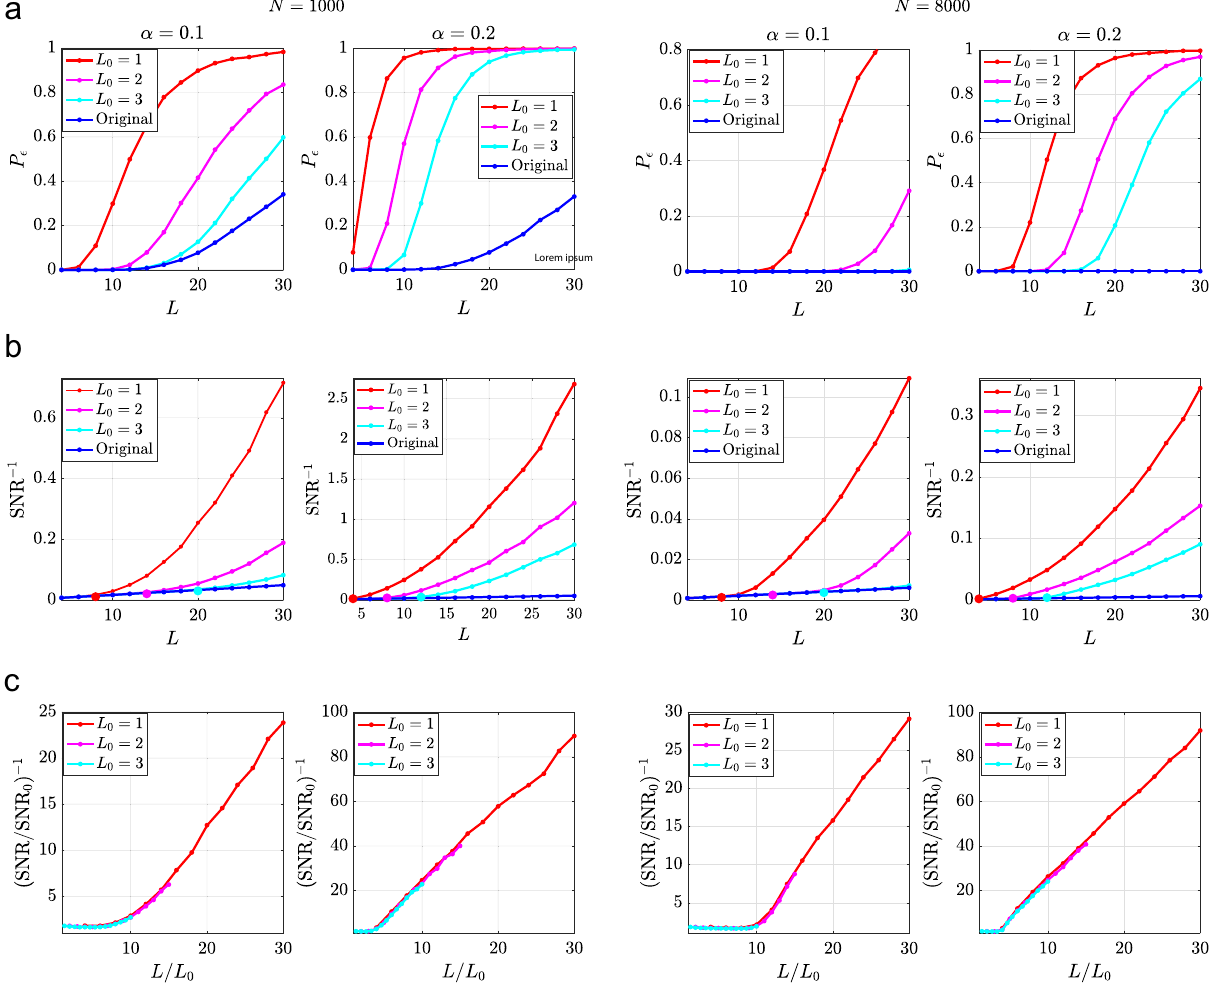
Figure 3. ( a ) The decoding error P ǫ is compared for several values of L 0 from structures containing L pairs of 1 items for two values of N and two values of α . ( b ) SNR − v. L . For each value of L 0 , l c is given by the value of L 1 where SNR − diverges from the line corresponding to the original structure, which is marked for each value 1 20 parallel updates are used in memory N T of L 0 . ( c ) ( SNR / SNR 0 ) − v. L L where SNR 0 L . For all figures, 0 = = 30 N retrieval and the average is performed over 10, 000 memories. The dictionary is fixed to D = Length of cueing structure and memory basins. As seen in Fig. 3, the performance worsens (and L 0 SNR decreases) as L increases, while the converse holds true for L 0 . We find that there is a critical ratio, l c L , = defined as the minimum initial cue (relative to the total length), that leads to very small error which is essentially L 0 2 m 0 corresponding memorized structure, which we denote m 0 . For small values of L 0 , m 0 π L . The size of ≈ (cid:31)